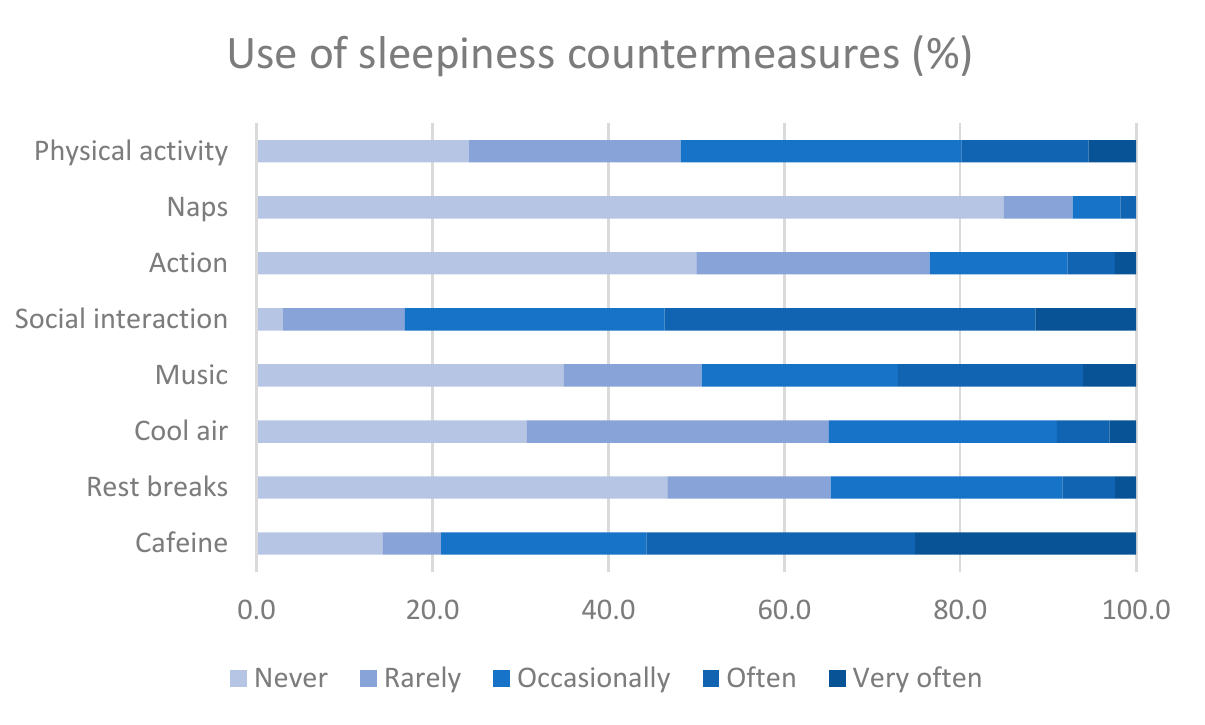
Figure 2. Frequency distribution for the use of countermeasures during navigation.